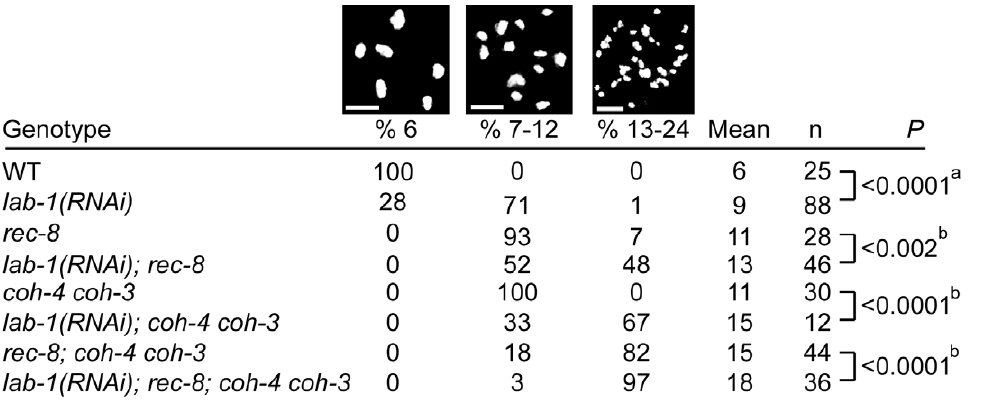
Figure 5. lab-1 depletion weakens sister chromatid cohesion. Number of DAPI-stained bodies in the 2 1 oocyte at diakinesis in the indicated genotypes. The p values were calculated by (a) the Wilcoxon signed-rank test and by (b) the two-tailed Mann-Whitney test, 95% C.I. Bars, 4 m M.